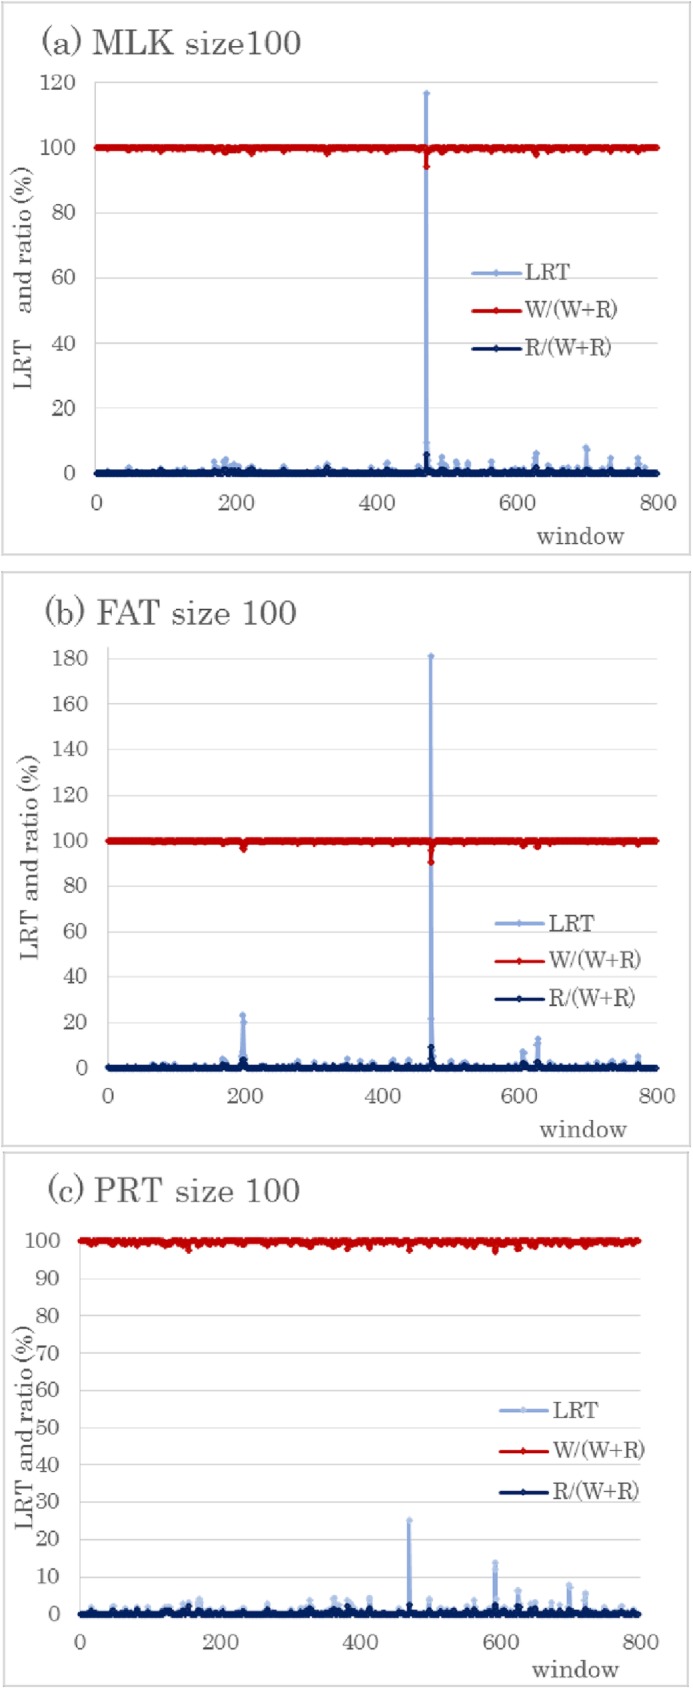
LRT and percentages of regional (R) and whole genomic variances (W) in total genomic variances (W+R) for three yield traits: (a) milk (MLK), (b) fat (FAT), and (c) protein yield (PRT). The vertical axis indicates the likelihood ratio test (LRT) and ratio (%), and the horizontal axis shows the window number across the genome. In total, 798 windows, each using 100 SNPs, were examined.